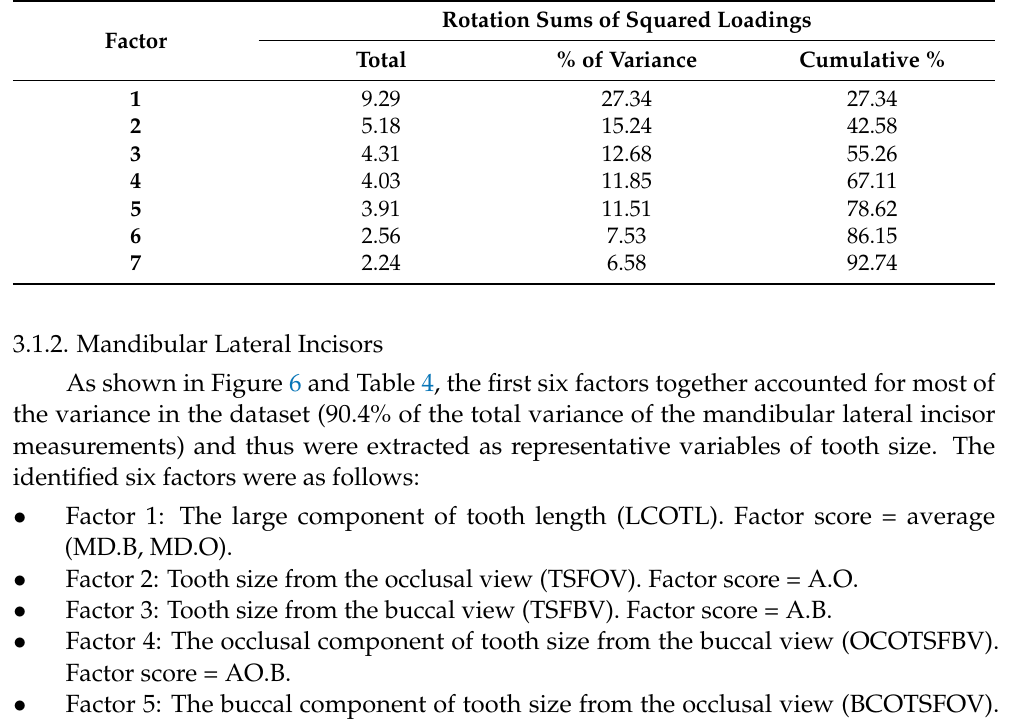
Figure 5. Scree plot, before rotation, for factor extraction of mandibular central incisor size variables in the supernumerary group. Table 3. Total and percent variance of the first seven factors for mandibular central incisor size variables in the supernumerary group. Note: The “Rotation Sums of Squared Loadings” shows factor variance after rotation (Varimax) which was used to transform the initial matrix into one that is easier to